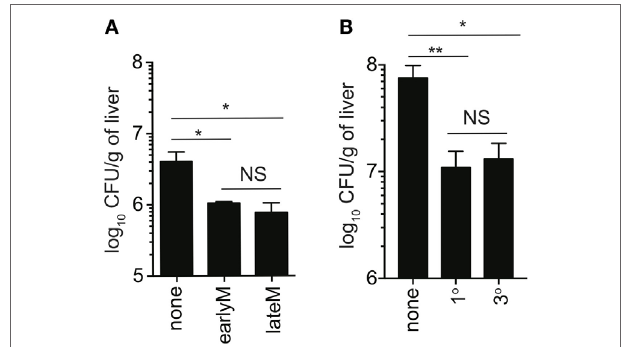
FigUre 7 | Ability to provide protection against unrelated LM infection is not influenced by time after initial antigen (Ag) encounter or Ag-encounter history. IFN- γ knockout mice either received or did not receive adoptive transfer of 400,000 1° earlyM or lateM P14 cells (a) , or 1° or 3° earlyM P14 cells (B) , and were infected with Vir LM [ (a) 0.8 × 10 4 CFU and (B) 1.3 × 10 4 CFU]. Approximately 1.5 (a) to 2.5 (B) days after infection, livers were harvested and bacterial colony forming units were enumerated. (a) Summary bar graph of LM colonies detected in livers of IFN- γ knockout mice that received adoptive transfer of the indicated populations of 1° memory P14 cells. n = 3 mice/group. Representative data from one of three independent experiments. Bars represent mean ± SEM. ANOVA with Bonferroni posttest; NS, not significant, * p < 0.05. (B) Summary bar graph of LM colonies detected in livers of IFN- γ knockout mice that received adoptive transfer of the indicated populations of 1° or 3° earlyM P14 cells. n = 3 mice/ group. Representative data from one of three independent experiments. Bars represent mean ± SEM. ANOVA with Bonferroni posttest; NS, not significant, * p < 0.05, ** p <